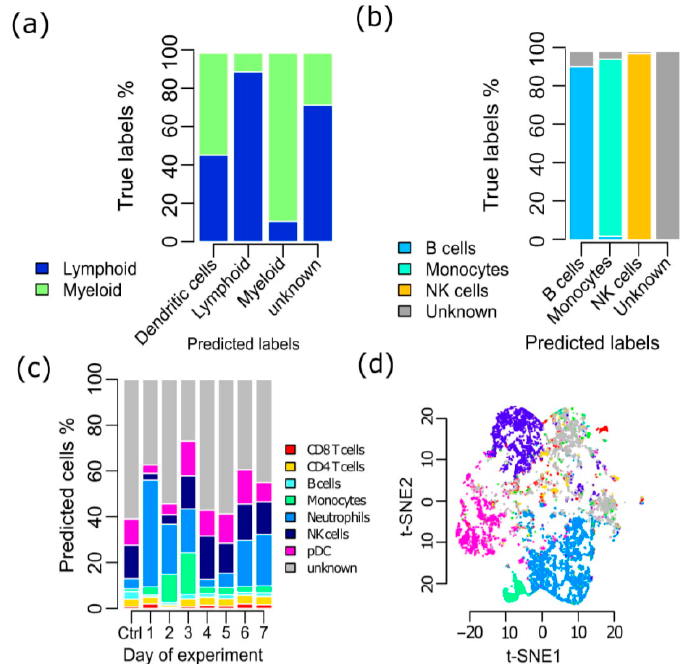
Figure 3. Validation of SCINA on real data ( a ) SCINA identified the cell types of CD45 + single cells enriched from Renal Cell Carcinomas (RCCs). Dendritic cells were left out of this analysis, as they could be of either lymphoid or myeloid lineage. ( b ) SCINA identified the cell types in a pool of cells comprised of B cells, monocytes, NK cells, and a “pseudo” unknown cell type. ( c ) SCINA was used to analyze the mouse CyTOF data collected each day following gland injury, which profiled an average of 389,777 cells at each time point. ( d ) t-SNE was used to analyze the same mouse CyTOF dataset. The cells were colored by cell types assigned by SCINA.